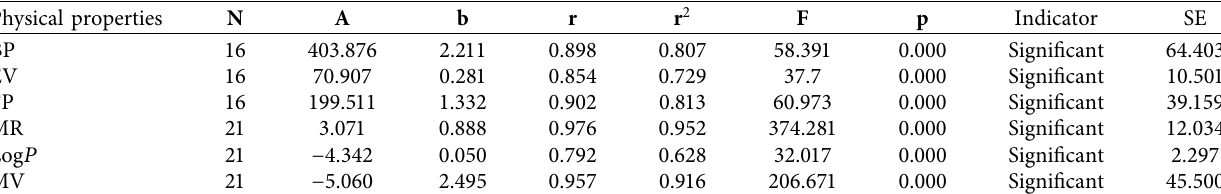
Table 12: Statistical specifications for the linear model of SO ( G ) .